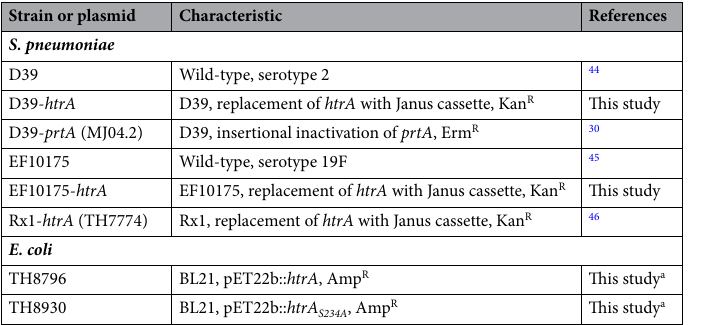
Table 1. Strains used in this study. a Isolates were kindly provided by Dr. Jing-Ren Zhang, Tsinghua University, School of Medicine, Beijing,